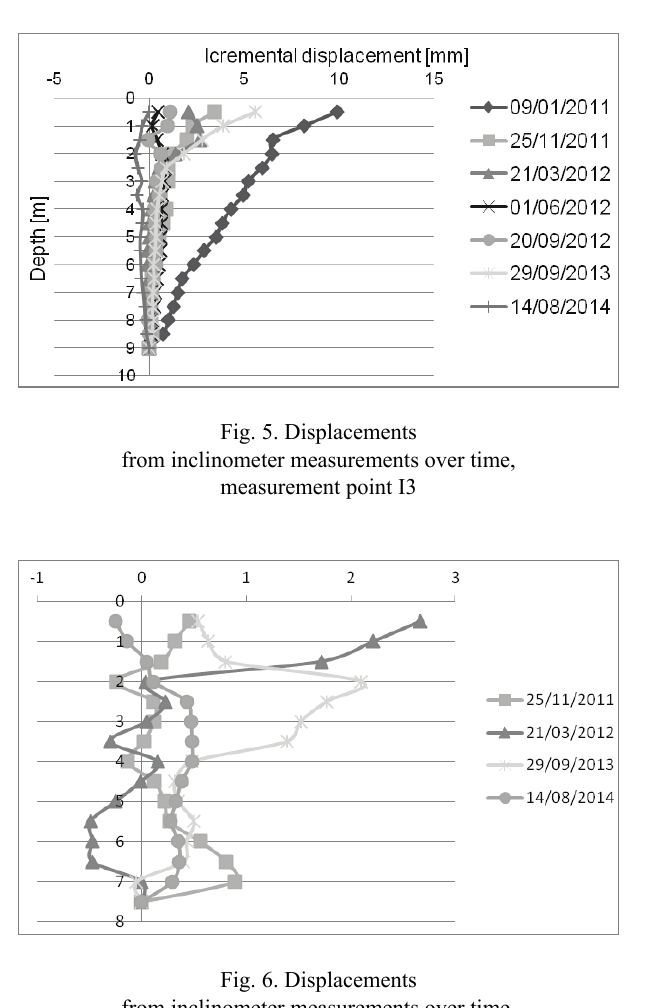
Fig. 4. Displacements from inclinometer measurements over time, measurement point I2